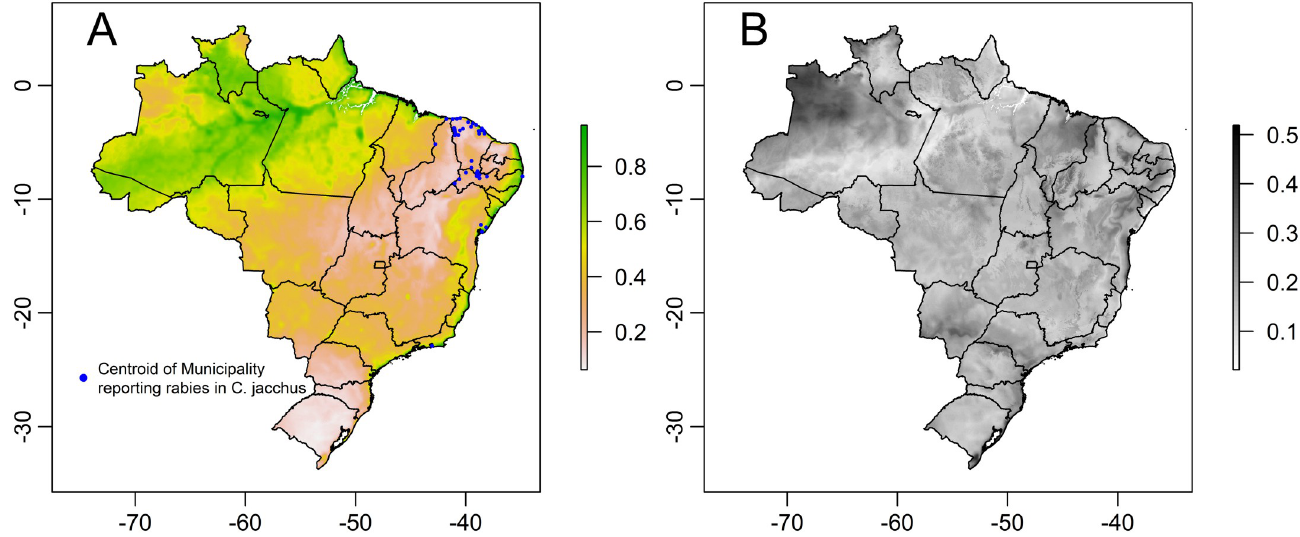
Fig 5. Model predictions on Callithrix jacchus suitable area in Brazil. (A) Predicted suitable areas of Callithrix jacchus across Brazil (median values of the best fitting model). Areas in darker red indicate higher suitable areas predicted by the best Maxent model. Blue dots represent the centroid of municipalities that have reported a rabies case in C . jacchus (B) Uncertainty associated with the predicted suitable areas of Callithrix jacchus in Brazil. Uncertainty is represented by the range of the model predictions (max-min). Country, region and district maps were obtained from the GADM (http://www.gadm.org//) database, freely-available for academic use, using the getData function from the raster package of R (map layer can be found here: https://biogeo.ucdavis.edu/data/gadm3.6/Rsp/gadm36_ BRA_2_sp.rds).